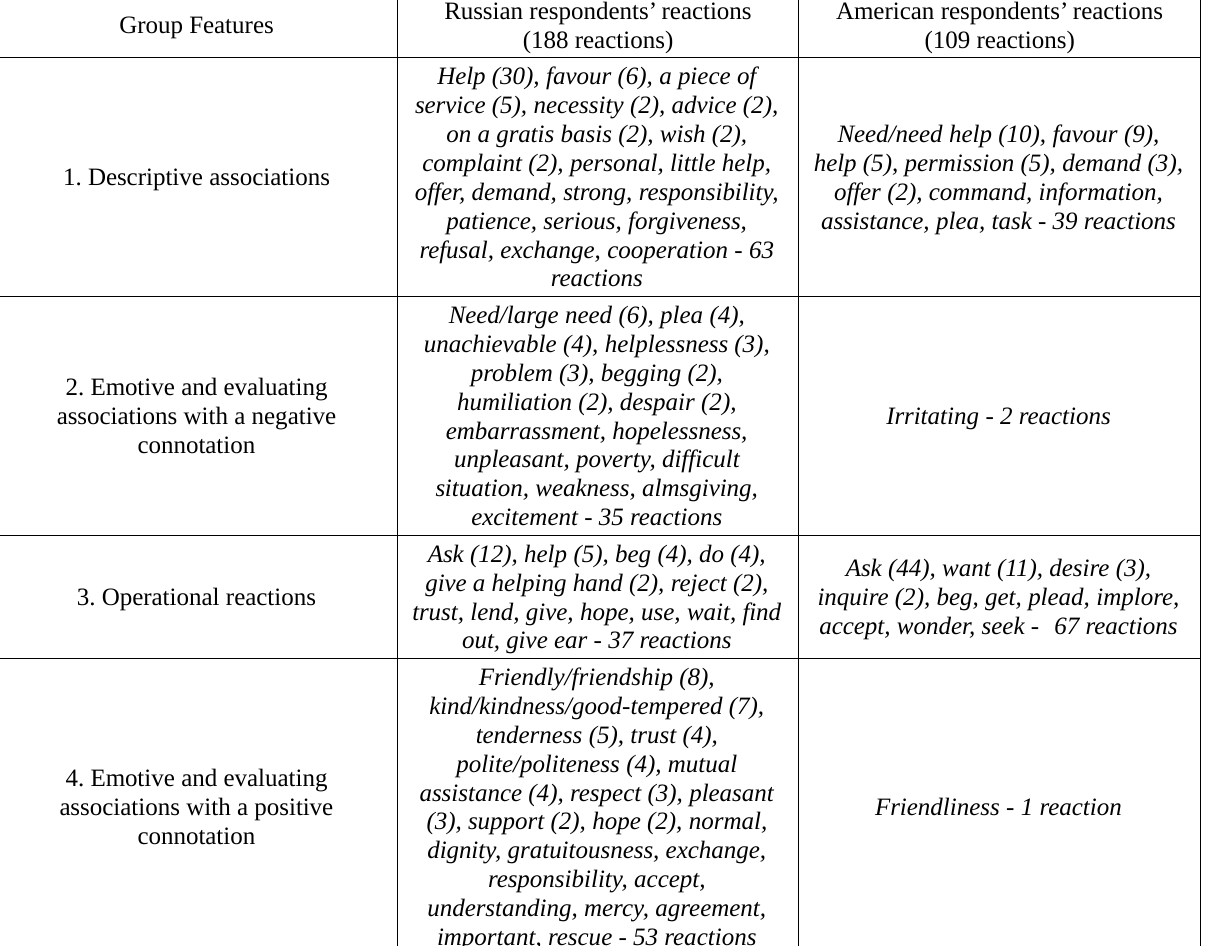
Table 1 - The correlation of the Russian and American respondents’